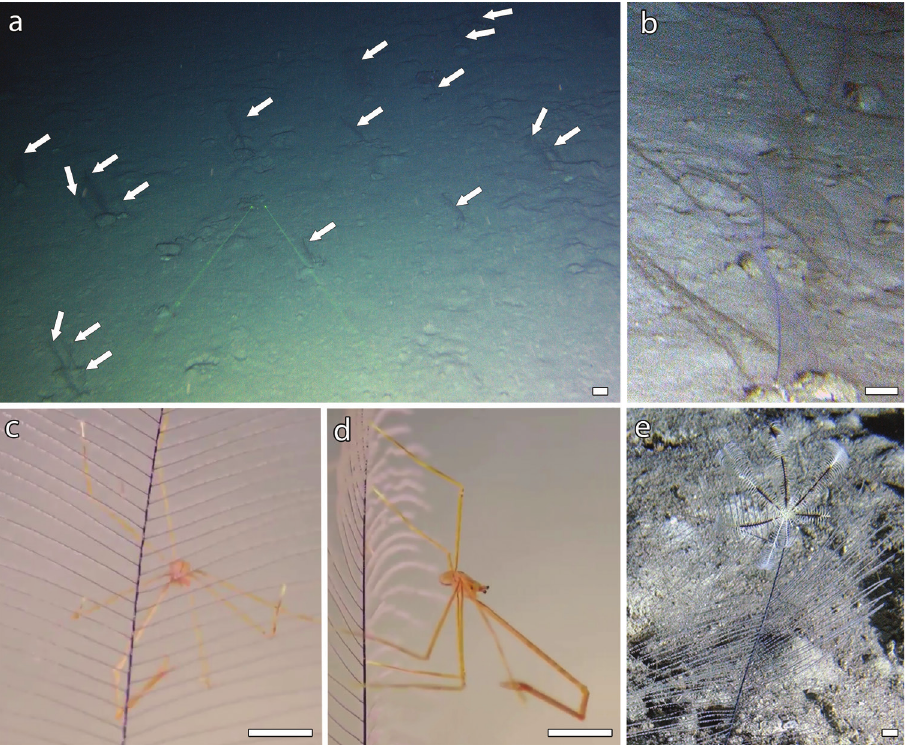
Figure 6. Distribution and associations of Bathypathes thermophila sp. nov. a aggregations of colonies (white arrows) b detail of four co-occurring colonies. Epibionts c, d unidentified spider crabs e unidenti- fied crinoid. Scale bars: 10 cm ( a, b ); 1 cm ( c–e